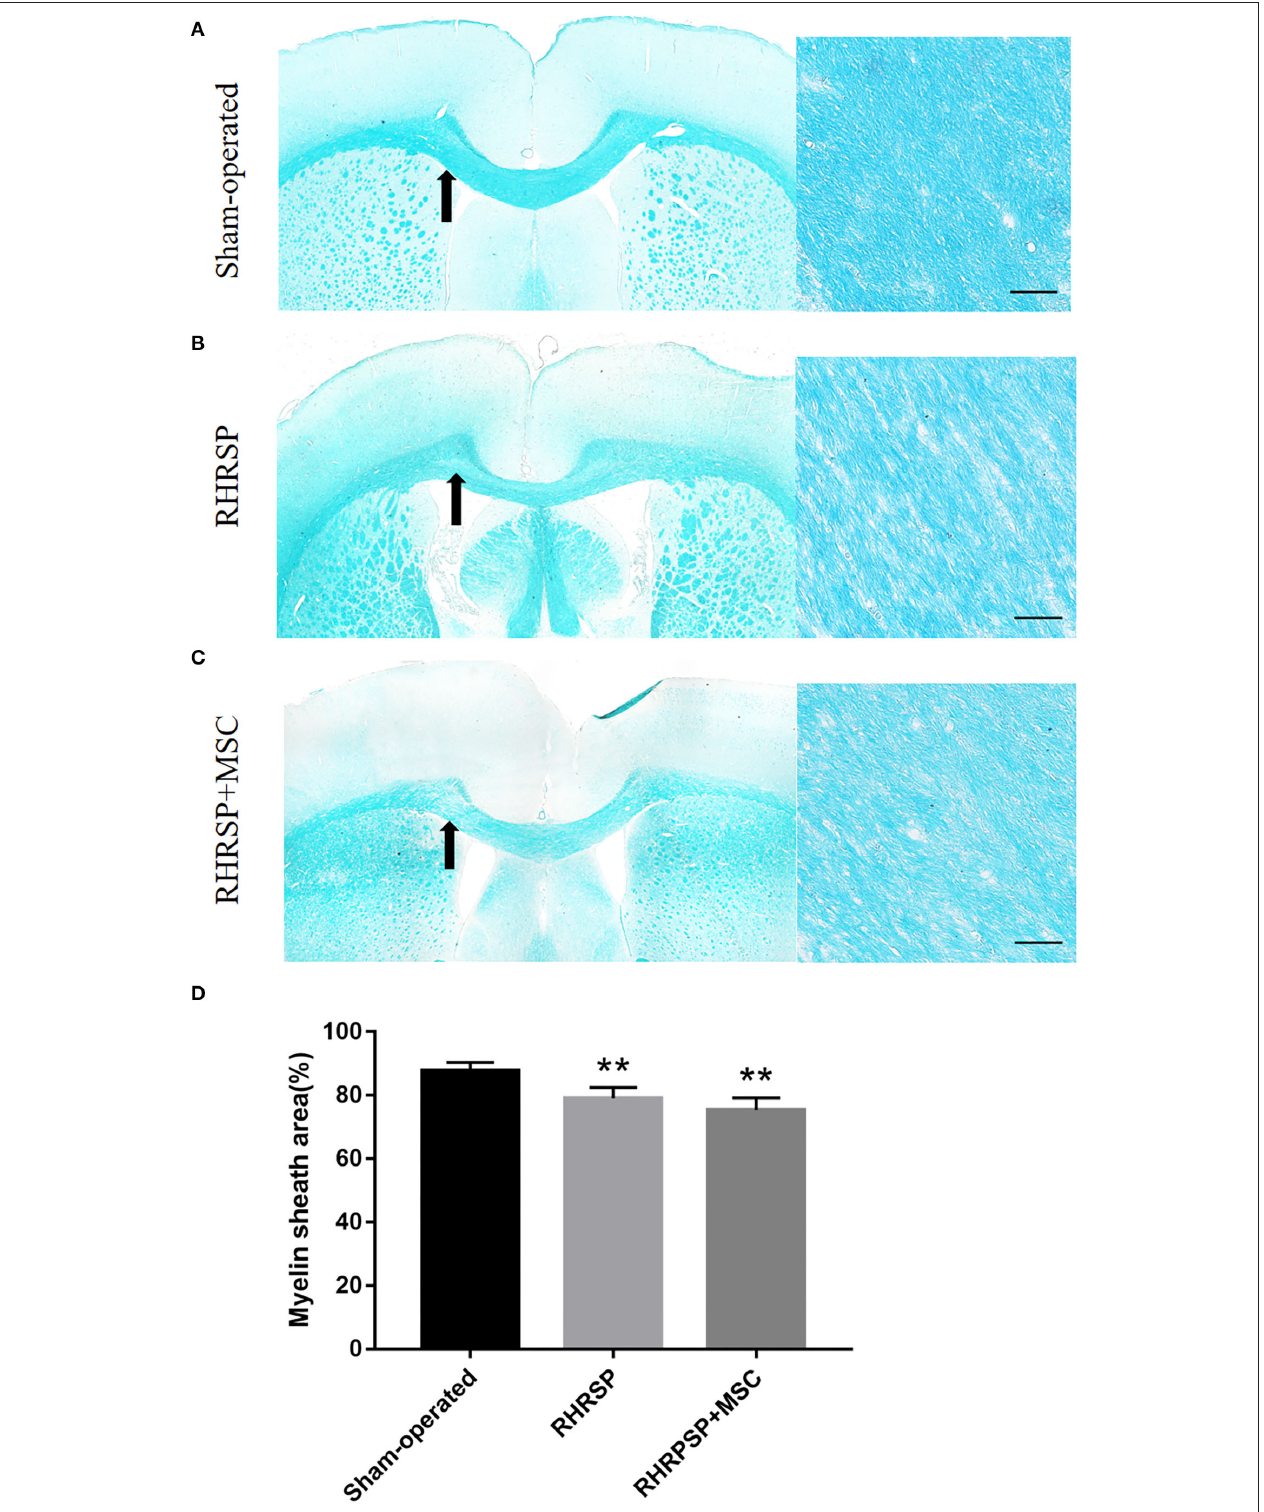
FIGURE 3 | LFB staining of white matter. (A–C) Representative images of LFB staining of Sham-operated, RHRSP and RHRSP + MSC groups. Arrows indicate the main observation area. (D) Quantification of myelin sheath area (** P < 0.01, vs. Sham-operated group; n = 6/group). scale bar = 50 µ m.